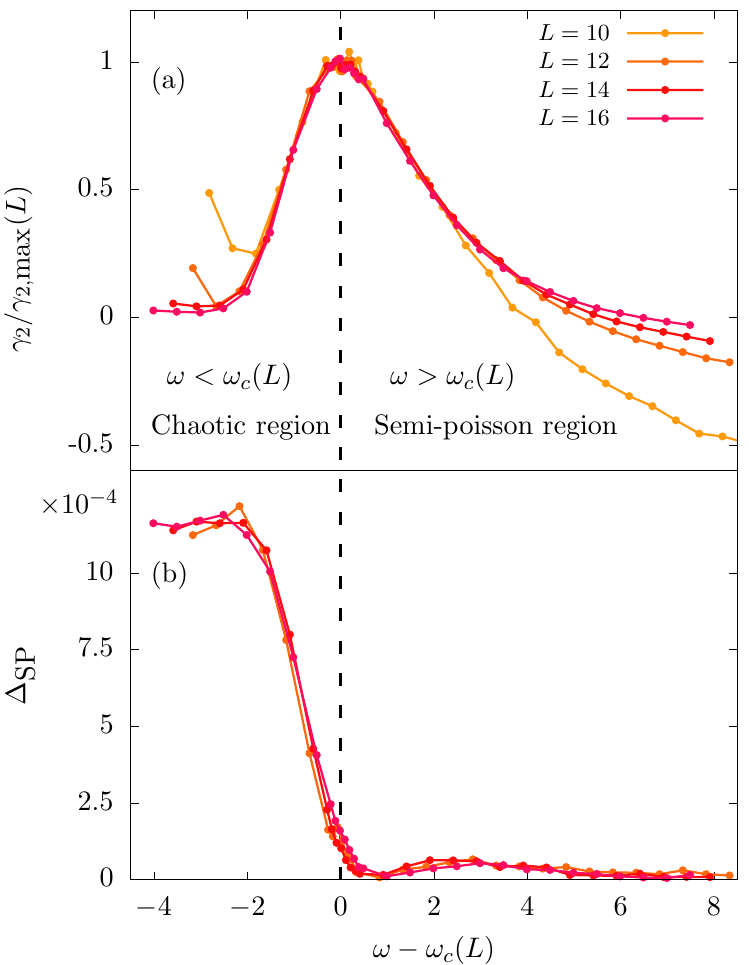
Figure 8: (a): Kurtosis excess of the distribution of (cid:101) ∆ , re-scaled with its maximum n ( L ) , for L = 10, 12, 14, value for each system size, γ , as a function of ω − ω c 2,max ( L ) . (b): Distance and 16. The black, dashed line shows the singular point, ω = ω c between the numerical NNSD and the family of intermediate statistics Eq. (11), ∆ , SP ( L ) , for L = 12, 14, and as a function of ω − ω c